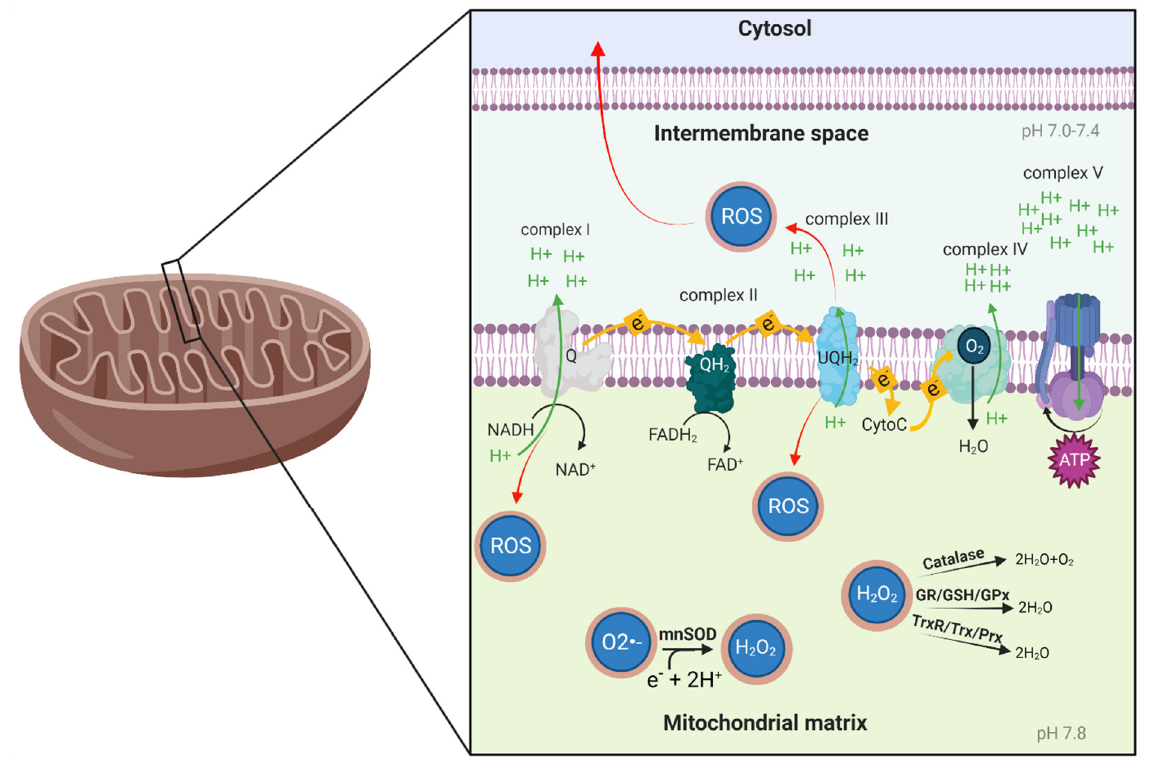
Figure 1. Oxidative phosphorylation process and oxidative stress balance. NADH, a product of the citric acid cycle, is oxidized to NAD + at complex I, transferring an electron to ubiquinone (Q). At complex II, FADH 2 is oxidized to FAD + , transferring another electron to Q. When Q arrives at complex III, it transfers its electrons to cytochrome C (CytoC). At complex IV, the electrons carried by CytoC are drawn to diatomic oxygen (O 2 ) and together with hydrogen, they form H 2 O. In the electron transport chain process, complexes I, III and IV pump protons from the mitochondrial matrix to the intermembrane space, creating an electrochemical proton gradient and a membrane potential ( ∆ψ ) on the inner membrane of the mitochondria. Complex V (ATP synthase) uses the proton gradient to allow protons back into the mitochondrial matrix, synthesizing ATP in the process. Complexes I and III are the major sites of free radical production; if they release superoxide (O 2 • − ) to the mitochondrial matrix, mnSOD will transform it to H 2 O 2 . Then, depending on cell specificity, H 2 O 2 will be transformed to O 2 and H 2 O by catalase, or to H 2 O by glutathione reductase/glutathione peroxidase (GR/GPx) or thioredoxin reductase/peroxiredoxin (TrxR/Prx) activity, in the presence of respiration products (i.e., NADPH).